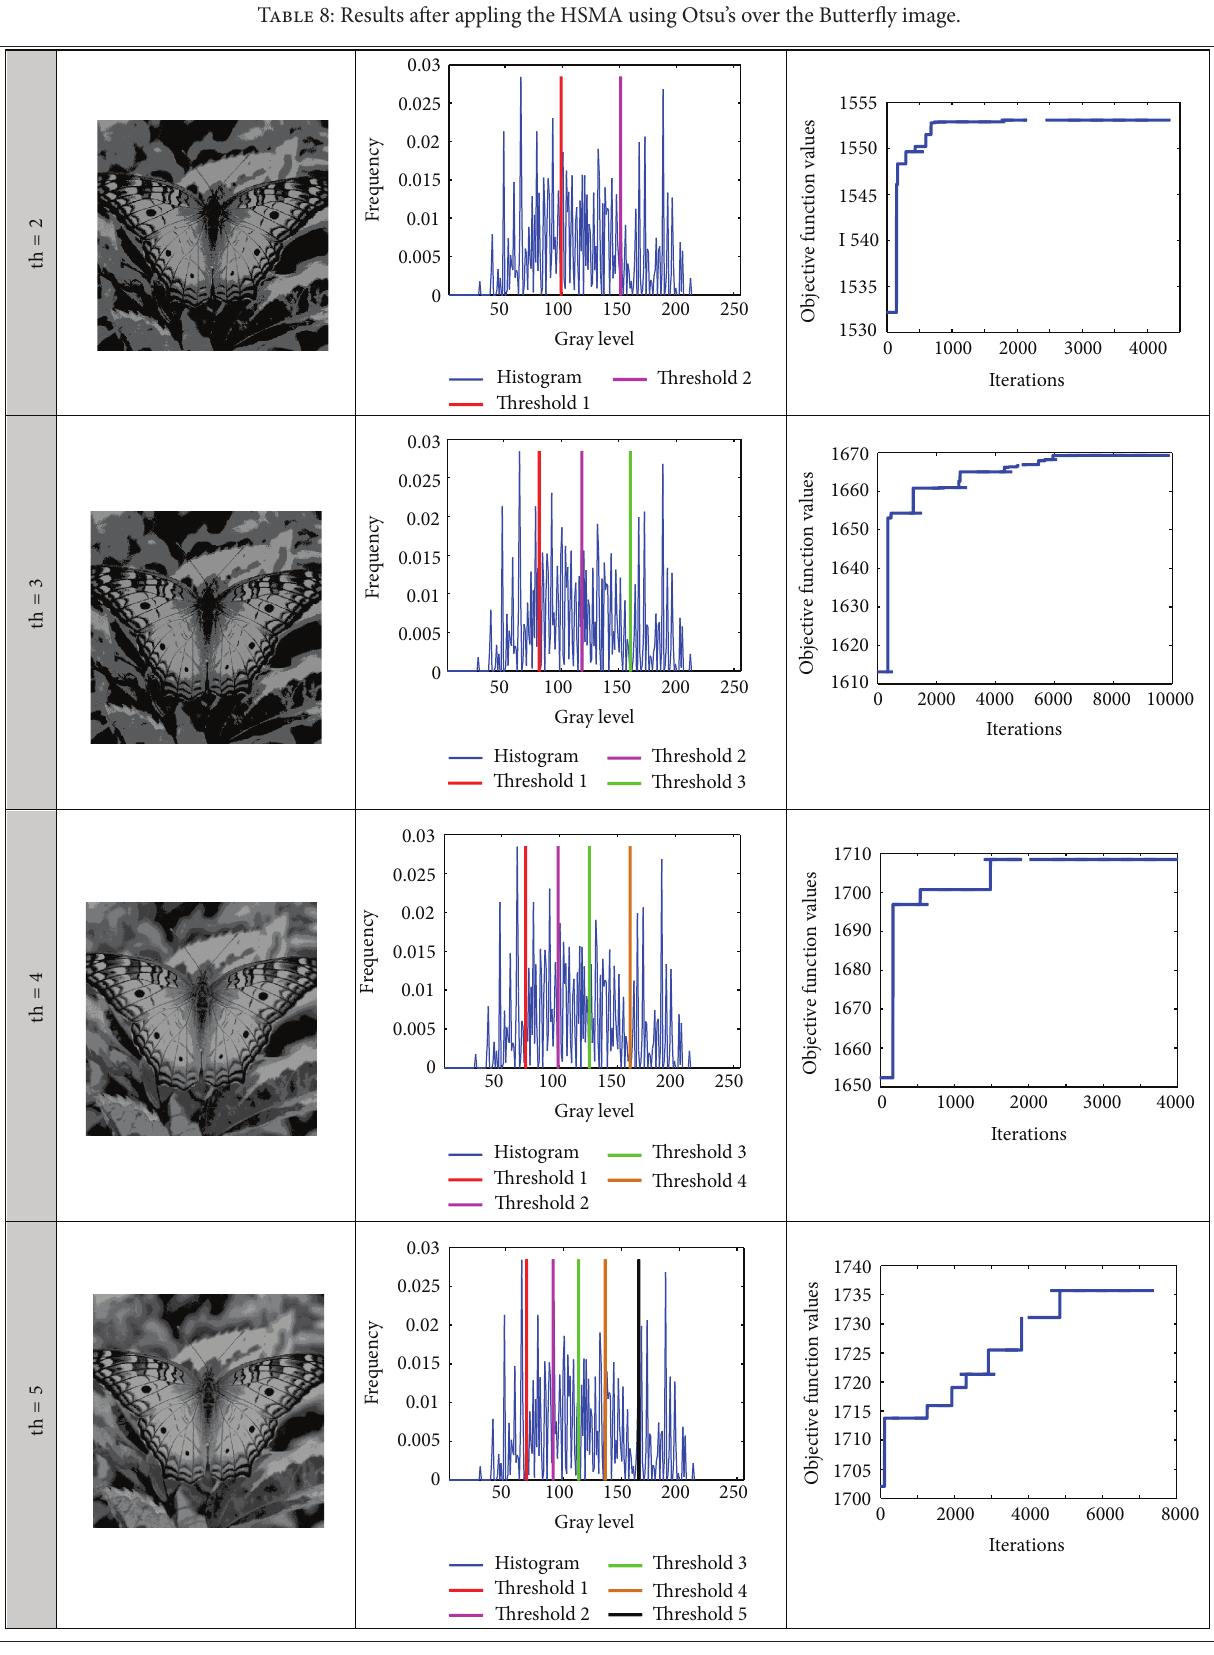
Table 8: Results after appling the HSMA using Otsu’s over the Butterfly